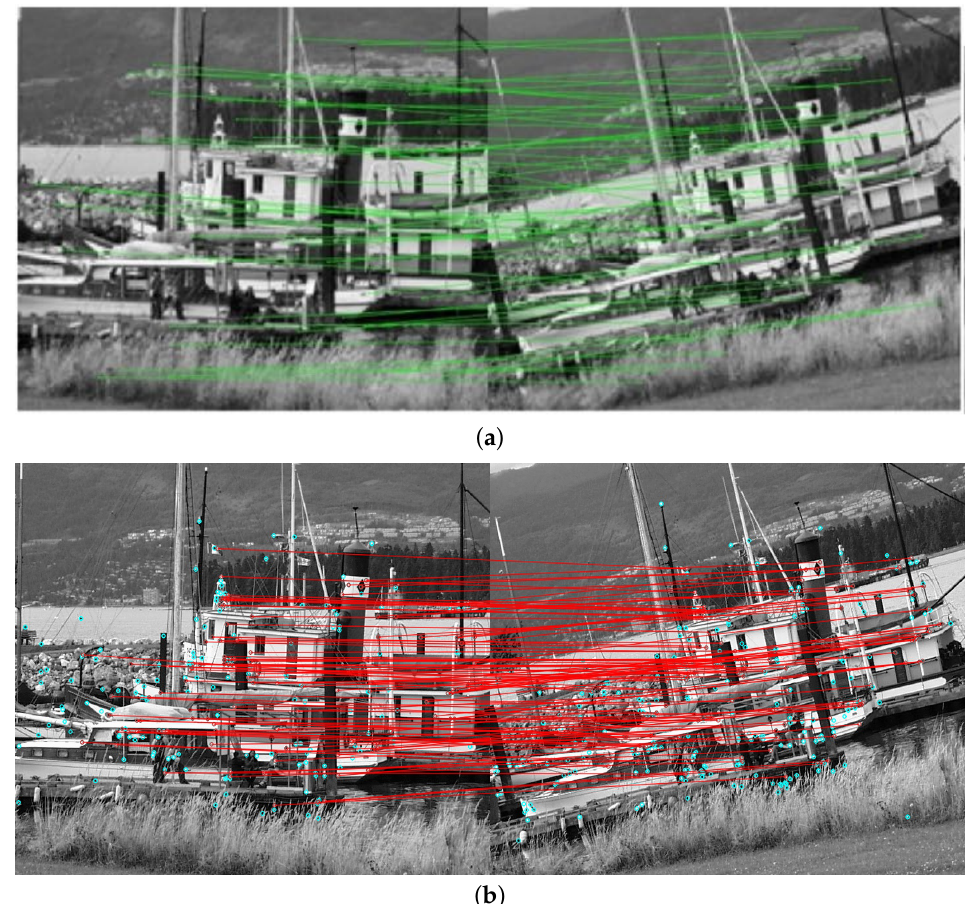
Figure 17. Matching results of images with different affine distortion. ( a ) The adaptive RKEM algorithm; ( b ) The algorithm in this